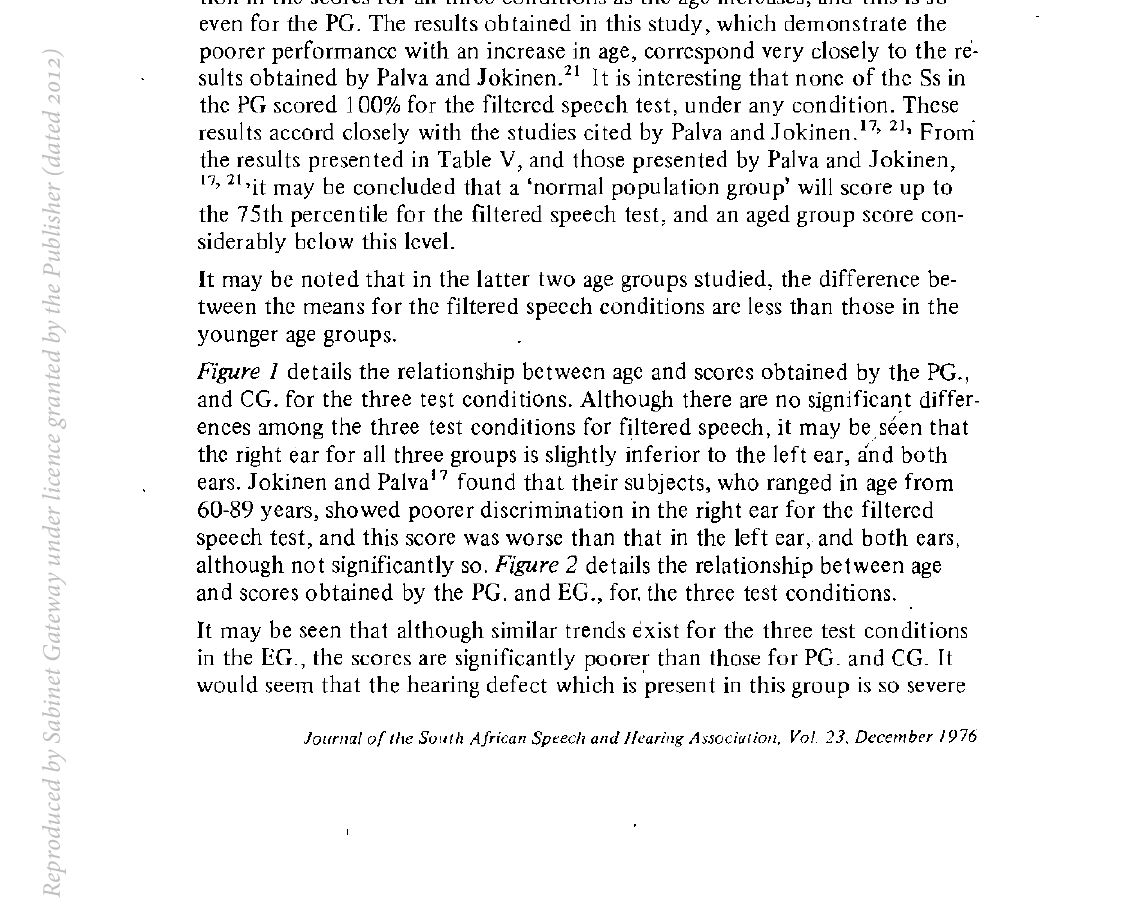
TABLE V. Mean Percentage Scores for Filtered Speech for the Right and Left Ears, and the Binaural Condition for the PG, CG and EG. Inspection of Table V once more indicates that all Ss in the PG. scored signifi- cantly better than the CG. who in turn scored significantly better than the